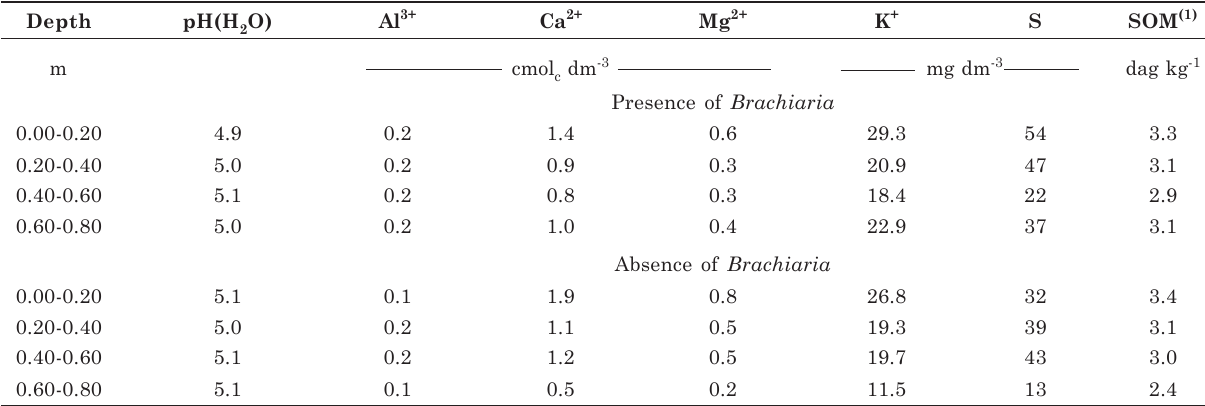
(1) SOM: soil organic